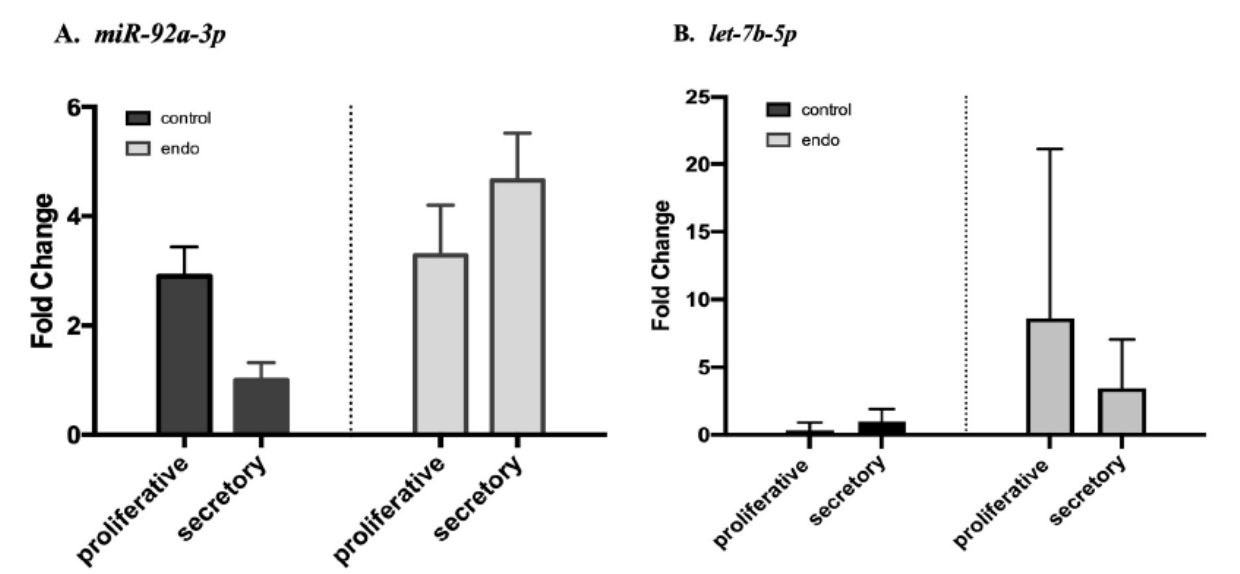
Figure 2. The effect of the menstrual cycle on miR-92a-3p and let-7b-5p levels of expression in plasma samples from the endometriosis and control groups. Endo: endometriosis group ( n = 93). Control: healthy patients ( n = 95). p -values are based on analysis by variances of the ANOVA test. ( A ) miR-92a-3p . ANOVA p = 0.003, interaction effect p = 0.032, post-hoc test (SNK) for endometriosis vs. controls p = 0.012. ( B ) let-7b-5p . ANOVA p = 0.045, interaction effect p = 0.253, post-hoc test (SNK) for endometriosis vs. controls p =